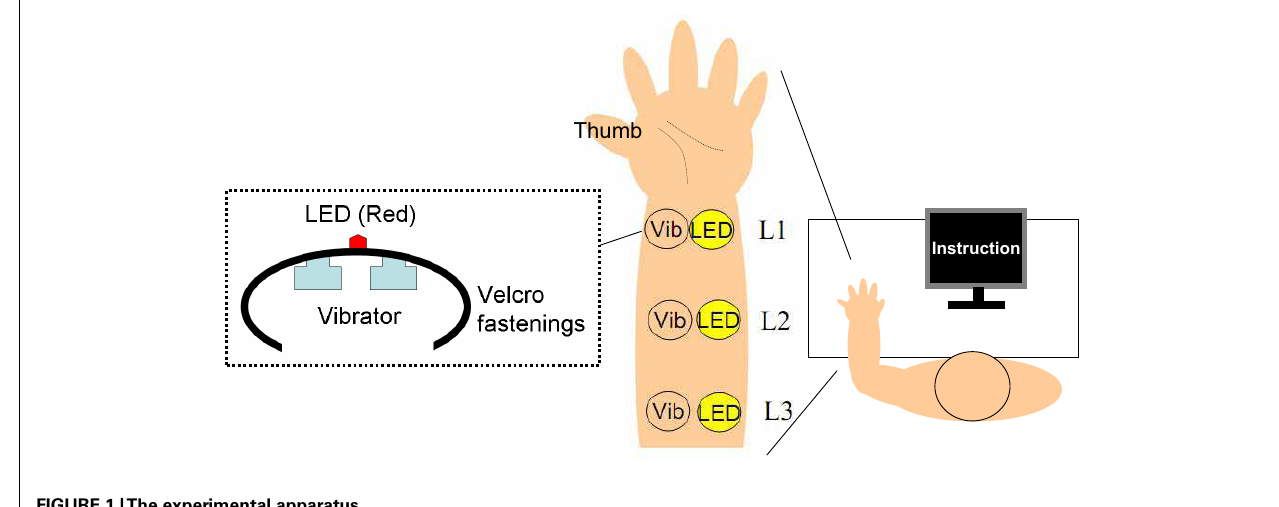
FIGURE 1 |The experimental